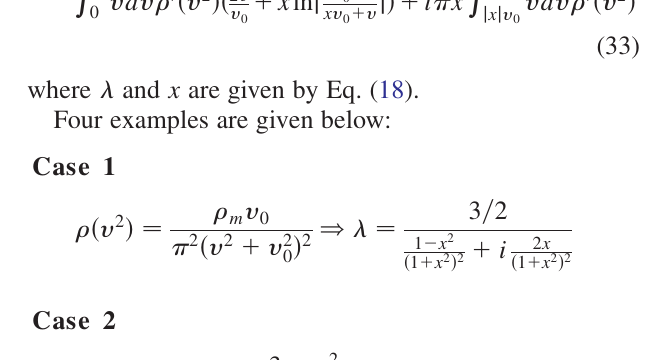
FIG. 4. (Color) Contours of constant growth rates, where H ð x; y Þ is the right-hand side of Eq.